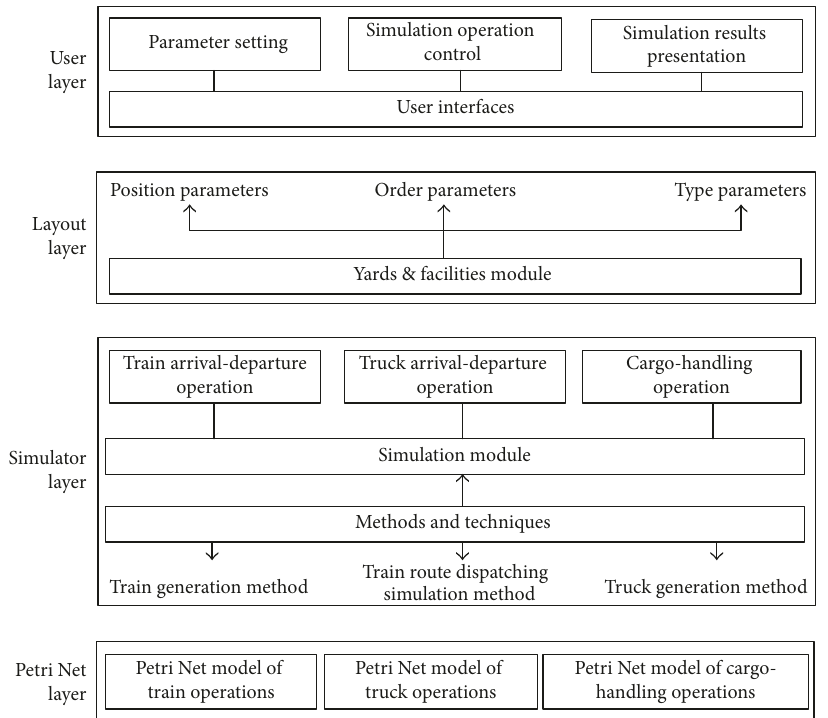
Figure 4: Framework of simulation